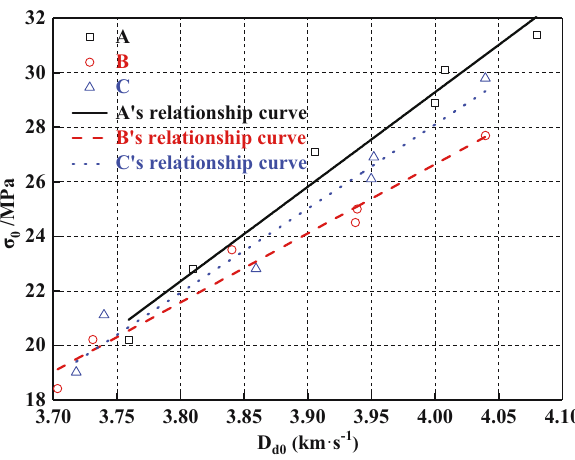
Figure 21: Relationship σ 0 with D d n